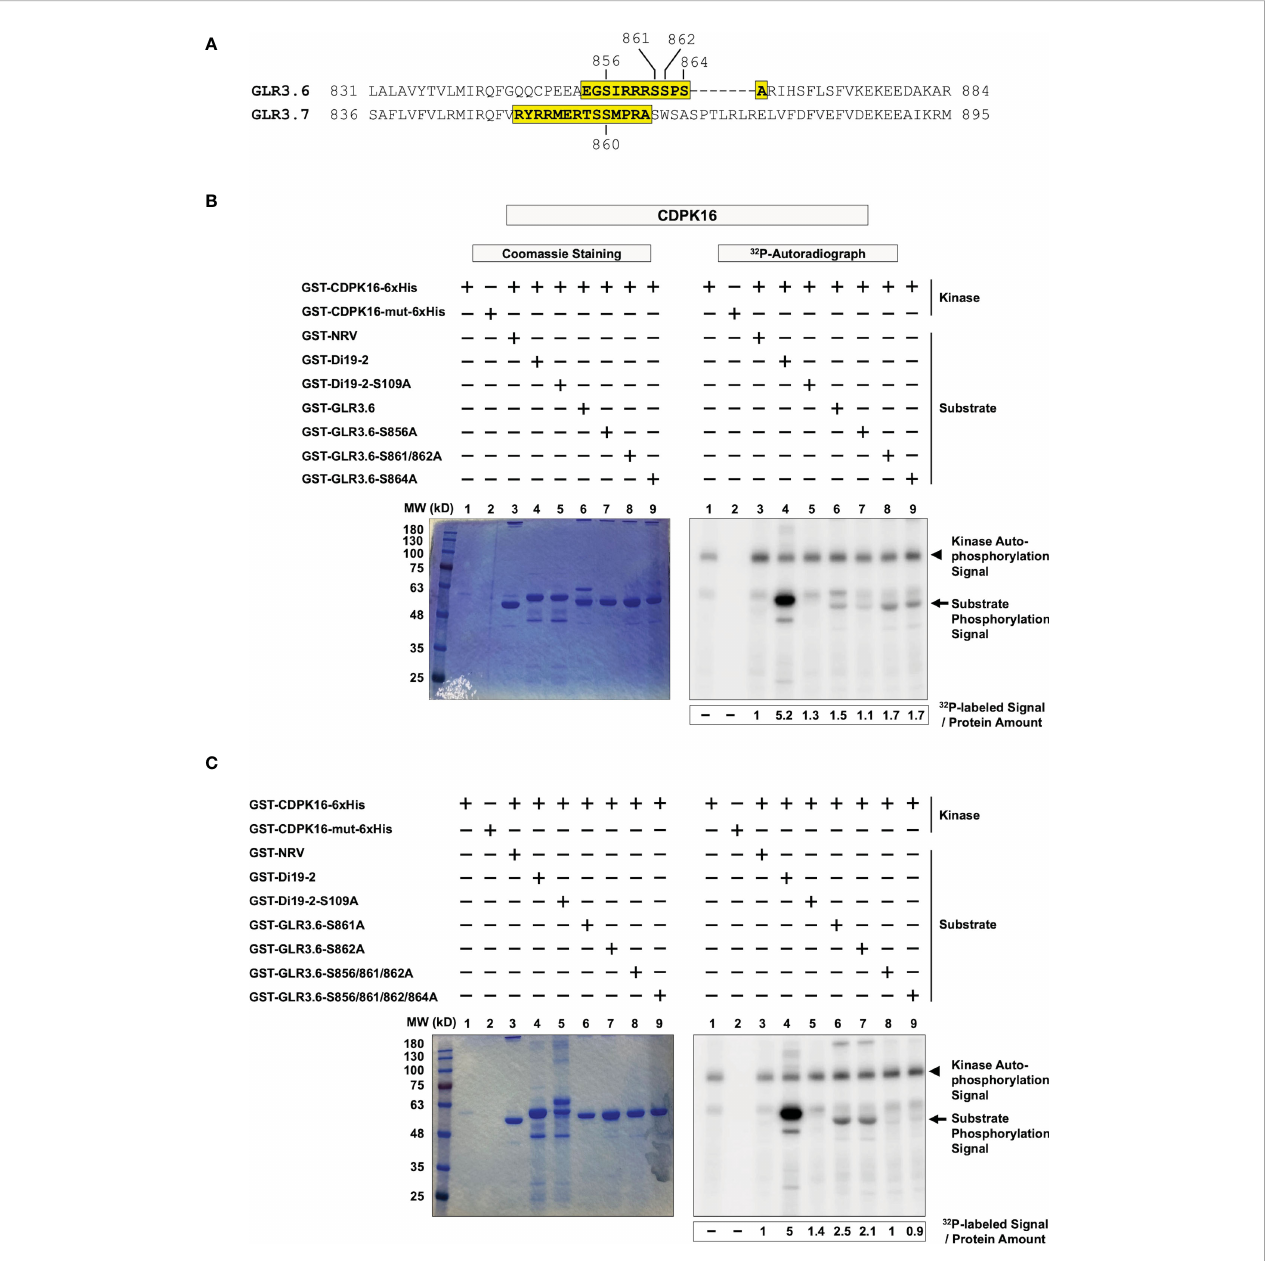
FIGURE 2 CDPK16 phosphorylates S856 of GLR3.6 in vitro . (A) The yellow-shaded fragments of GLR3.6 and GLR3.7 containing the 14-3-3 w binding motif were fused to GST then used as substrates for CDPK16 phosphorylation kinase assay. The Ser860 residue of GLR3.7 is phosphorylated by CDPK16, CDPK3, and CDPK34. The Ser856, Ser861, Ser862, and Ser864 residues of GLR3.6 are highlighted. They were tested for phosphorylation by CDPK16. Recombinant kinase-active GST-CDPK16-6xHis and kinase-dead GST-CDPK16-mut-6xHis were used to perform the kinase assay in vitro . (B) and (C) Substrates of the GST-fused peptides (5 – 10 m g) of GLR3.6, GLR3.6-S856A, GLR3.6-S861/862A, GLR3.6-S864A, GLR3.6-S861A, GLR3.6-S862A, GLR3.6-S856/861/862A, and GLR3.6-S856/861/862/864A, were analyzed. The well-known substrates GST-Di19-2 and GST-Di19-2-S109A were used as a positive and negative control, respectively. GST-NRV was used as a glutathione S-transferase (GST) tag control. Coomassie blue-staining gel shows the protein input (Left panels), and the corresponding 32 P-labeled autoradiograms (Right panels) are shown. The autophosphorylation signal of CDPK16 and the substrate phosphorylation signals are marked with arrowheads and arrows, respectively. The speci fi c 32 P-labeling intensity was calculated based on g - 32 P-labeled signals normalized to the band intensity of input with CBB